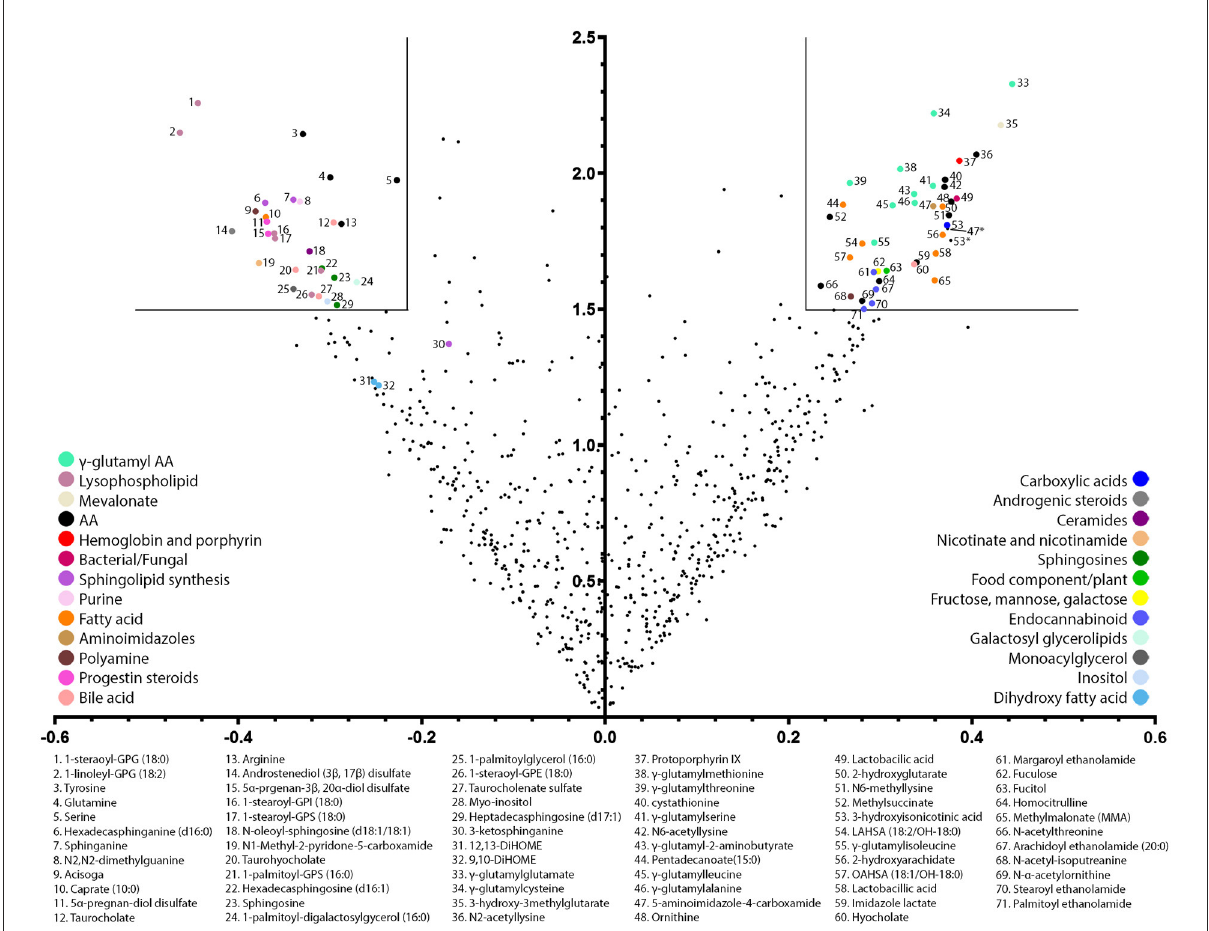
FIGURE1 Volcano plot of most discriminating stool metabolites between infants receiving a 2-HMO and control formula. The volcano plot is a scatter plot of variables in which the x-axis corresponds to the OPLS correlation coefficient (pcorr) and the y-axis to the OPLS variable influence on projection (VIP). Pre-filtering of the most influential variables was performed considered an OPLS coefficient above 0.22 and an OPLS VIP: threshold set at 1.5. Notably, 73 selected variables are color-coded according to their major metabolic pathway, and their biochemical names are